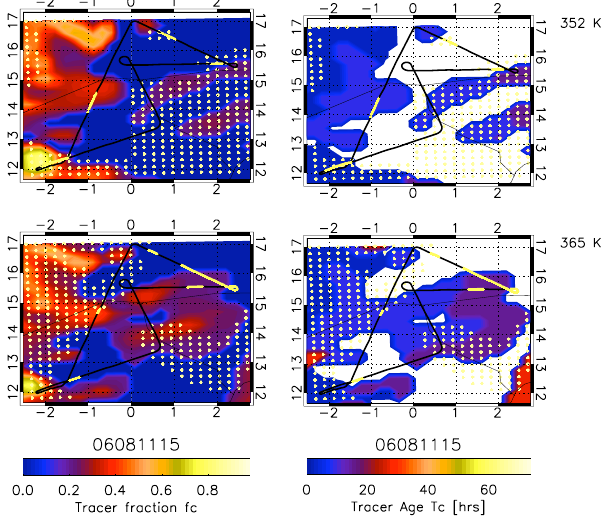
Fig. 9. As Fig. 7 but for the 11 August 2006